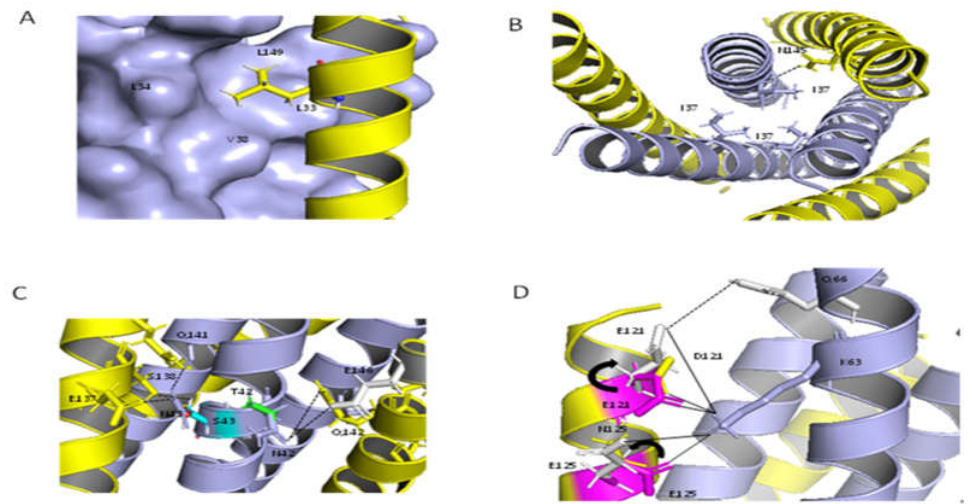
Figure 7. Structural basis of HIV-1 resistance to T20 and LP40. The effects of the resistance mutations on the binding stabilities of T20 or LP40 were analyzed using the crystal structure of T20/N39, shown as a ribbon model. Three N39 peptides are colored in blue, and three T20 peptides are colored in yellow. ( A , B ) The residues Leu33, Leu34, and Val38 are shown on the surface; Ile37 (colored in blue) and their interacting residues on N39, Leu149, and Asn147 (colored in yellow) are shown as stick models with labels. ( C ) Asn42 and Asn43 (colored blue), and their mutations, Thr42 and Ser43 (colored green and cyan), Glu137, Ser138, Glu142, and Gln144 on N39 (colored in yellow), and Glu146 on N44 (colored in gray), are shown as stick models with labels. ( D ) The effects of NDQEEDYN on the interactions of the viral NHR and CHR helices were analyzed using the crystal structure of N36/C34, shown as a ribbon model. N36 peptides are colored in blue, and the C34 peptides are colored in yellow. Asp121 (colored in yellow) and its mutation Glu121 (colored in magenta), and Asn125 (colored in yellow) and its mutation Glu125 (colored in magenta) are shown as stick models with labels. Their interacting residues on C34 and Lys63 (colored blue) are shown as stick models with labels. In order to confirm the interaction between Glu121, Glu125, and Lys63, we analyzed these interactions in SFT/N36; the conformations of Glu121 and Glu125 (colored in gray) in SFT are different from Glu121 and Glu125 (colored in magenta) in C34. The solid black lines indicate salt bridges, and the dashed lines indicate hydrogen bonds.